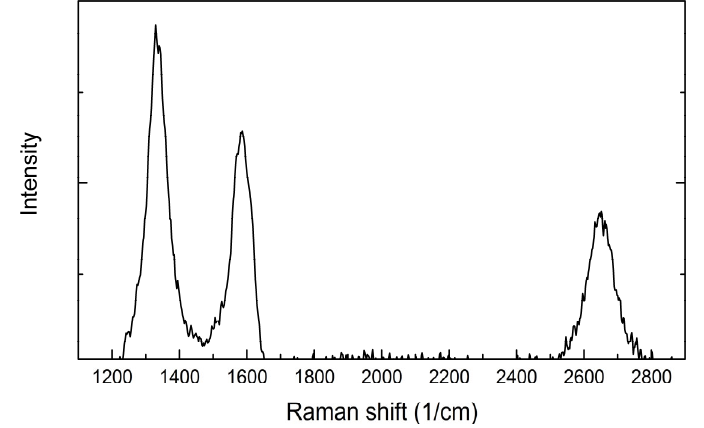
Figure 7. Raman spectrum of carbon in unsintered SiC